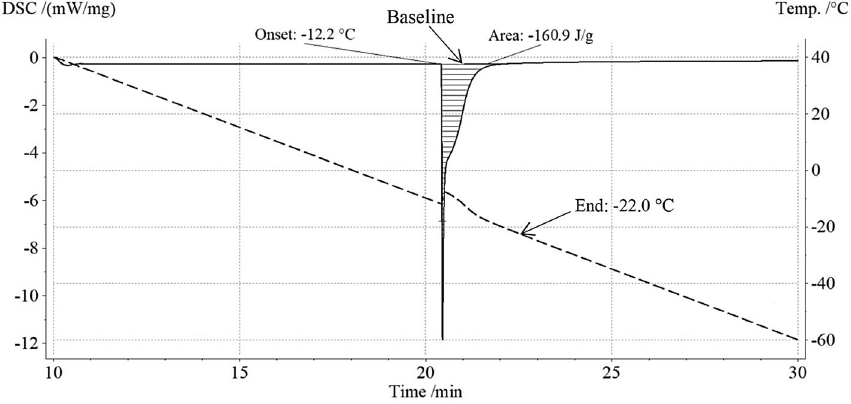
Figure 1. DSC signal and sample temperature vs